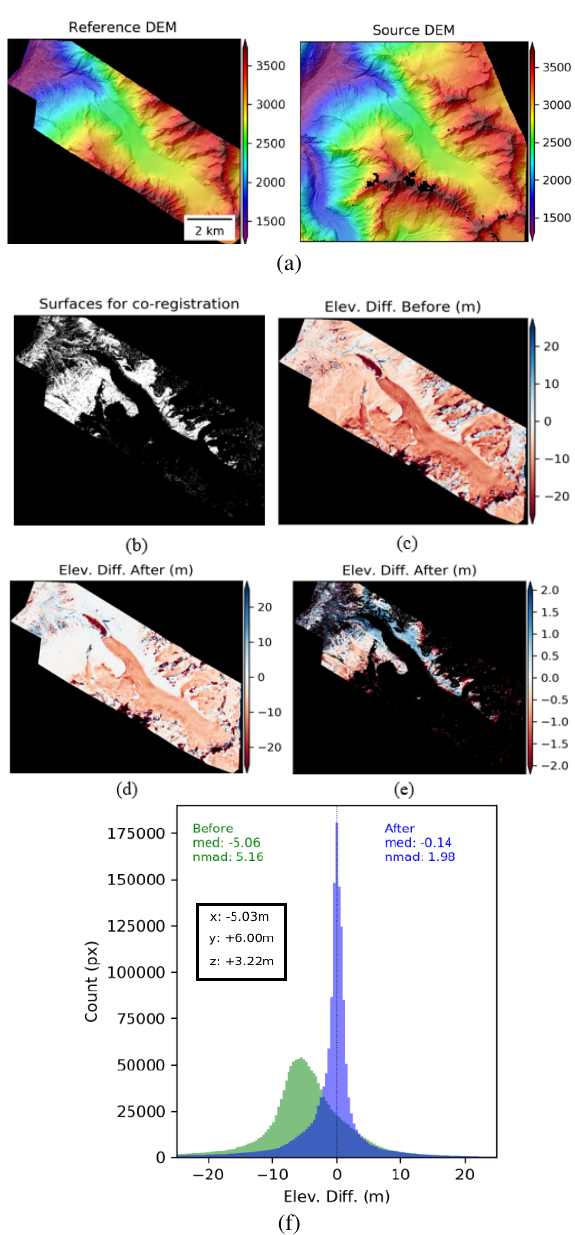
Figure 2. High resolution DEM processing chain for Pleiades stereo images Figure. 2e.